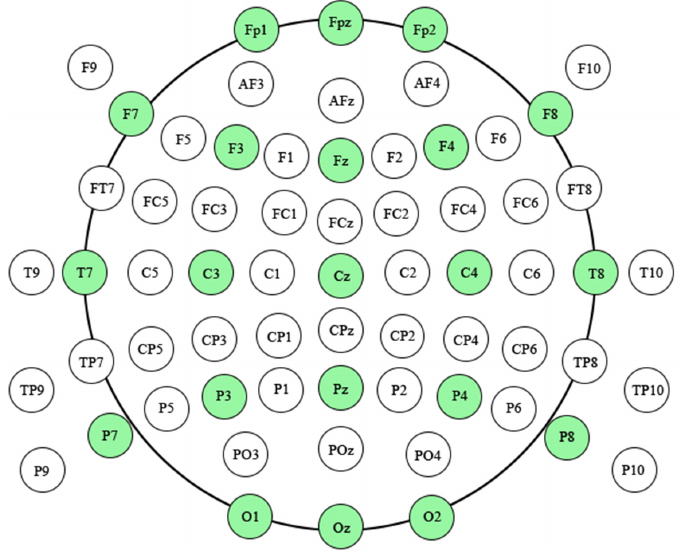
Figure 3. The horizontal distribution of scalp electrodes. The light green: canonical (21 out of 65) electrodes were used to construct the brain dynamic networks.